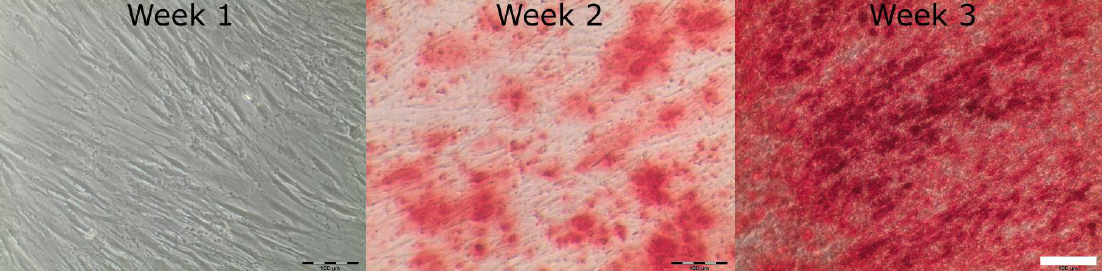
Figure A1. Cell aggregation of AD-MSCs in GelMA hydrogels (95% DoF) containing 0% and 2.5% hPL. Fluorescence pictures taken after one, three, and seven days of cultivation (4× objective and combined pictures). Scale bar 2000 µm per picture.